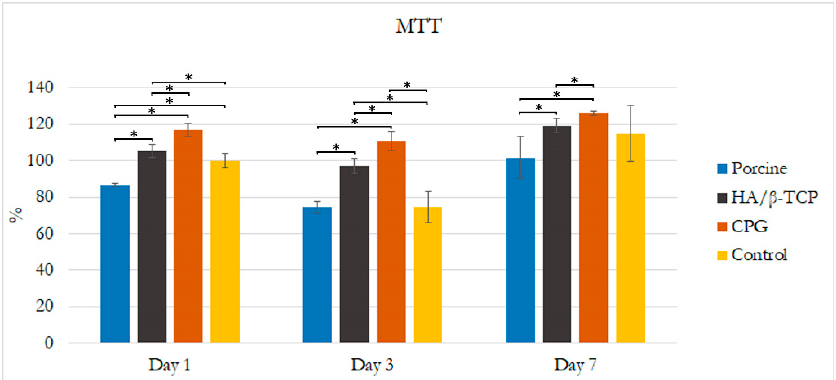
Figure 2. Effects of collagenated porcine graft (CPG), porcine graft, and hydroxyapatite and beta tricalcium phosphate (HA/ β -TCP) on MG-63 osteoblast-like cell viability. Cells were incubated from days 0–7. Results are expressed as percentages of control and are the means ± standard error. Statistically significant differences were set at p < 0.05 and are indicated by asterisks (*).